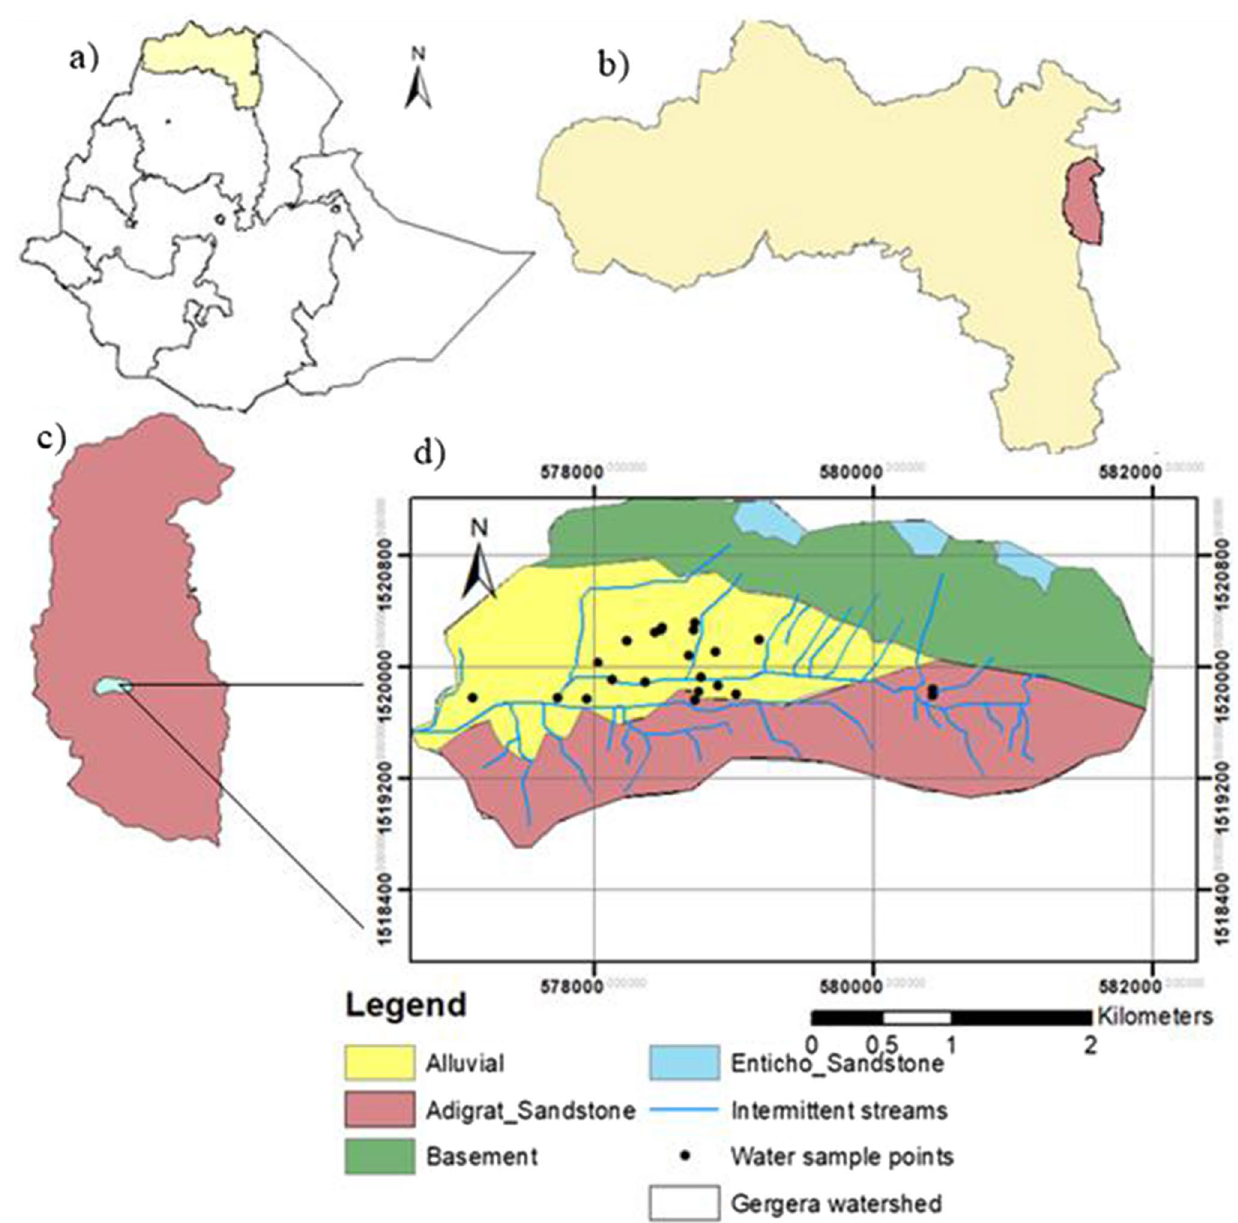
Fig. 1 Location of the study area: a Ethiopia, b Tigray indicating Atsbi Wemberta district, c Atsbi Wemberta indicating Gergera watershed in sub-district, and d Gergera watershed indicating geological classification, as well as intermittent streams and water sampling